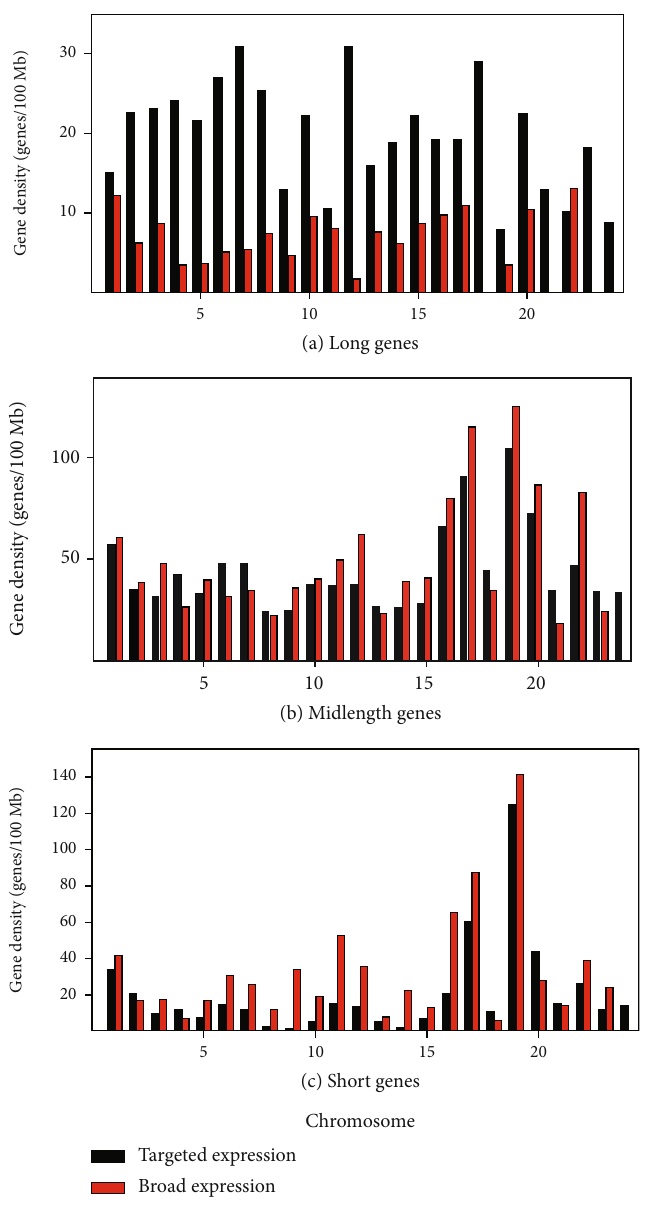
Figure 2: Distribution of short, midlength, and long genes among the 24 human chromosomes. Tissue-targeted genes are shown in black and broadly expressed in red. Note the higher proportion of long genes with tissue-targeted expression. Note also that the greater proportion of long, tissue-targeted genes is found in nearly all chromosomes (all but chromosome